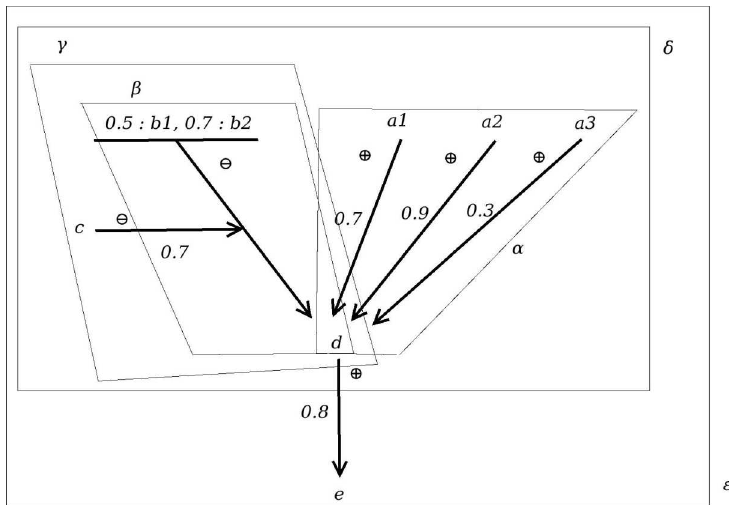
Figure 6. Example of a Bipolar Argumentation Graph with 5 evaluation steps α − ǫ . The argument in the graph starts with a convergent pro argument α and a linked contra argument β that is in turn attacked by a link attack γ . The pro and contra arguments together form a mixed bundle argument δ for standpoint d , which in turn forms the premise of a pro argument ǫ for standpoint e . Opponent and proponent roles are not assigned in this type of